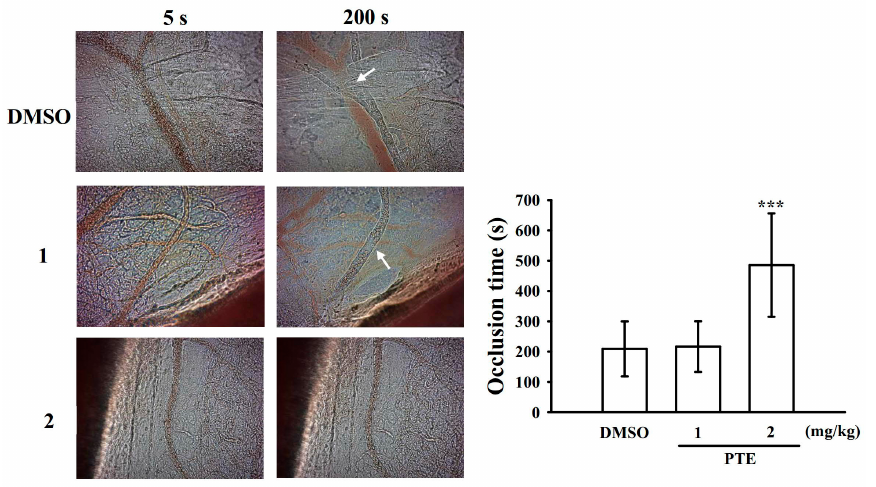
Figure 7. Effect of pterostilbene (PTE) on vascular thrombosis in the mesenteric venules of mice. Mice were administered an intravenous bolus of the solvent control (0.1% DMSO) or PTE (1 and 2 mg/kg), and the mesenteric venules were irradiated to induce microthrombus formation (occlusion time). Microscopic images (400× magnification) of 0.1% DMSO-treated controls and 1 and 2 mg/kg PTE-treated groups were recorded at 5 and 200 s after irradiation, respectively. The photographs shown are representative of eight similar experiments, and white arrows indicate platelet plug formation. Data are presented as the mean ± standard deviation ( n = 8). *** p < 0.001, compared with the 0.1% DMSO-treated group.